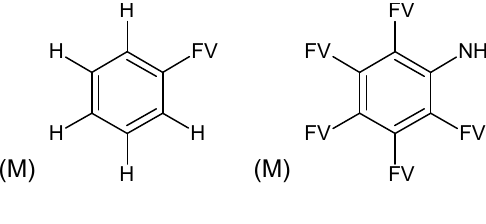
Figure 6. Substructures for Challenge 17. (M) indicates macroatom; FV = free valence.